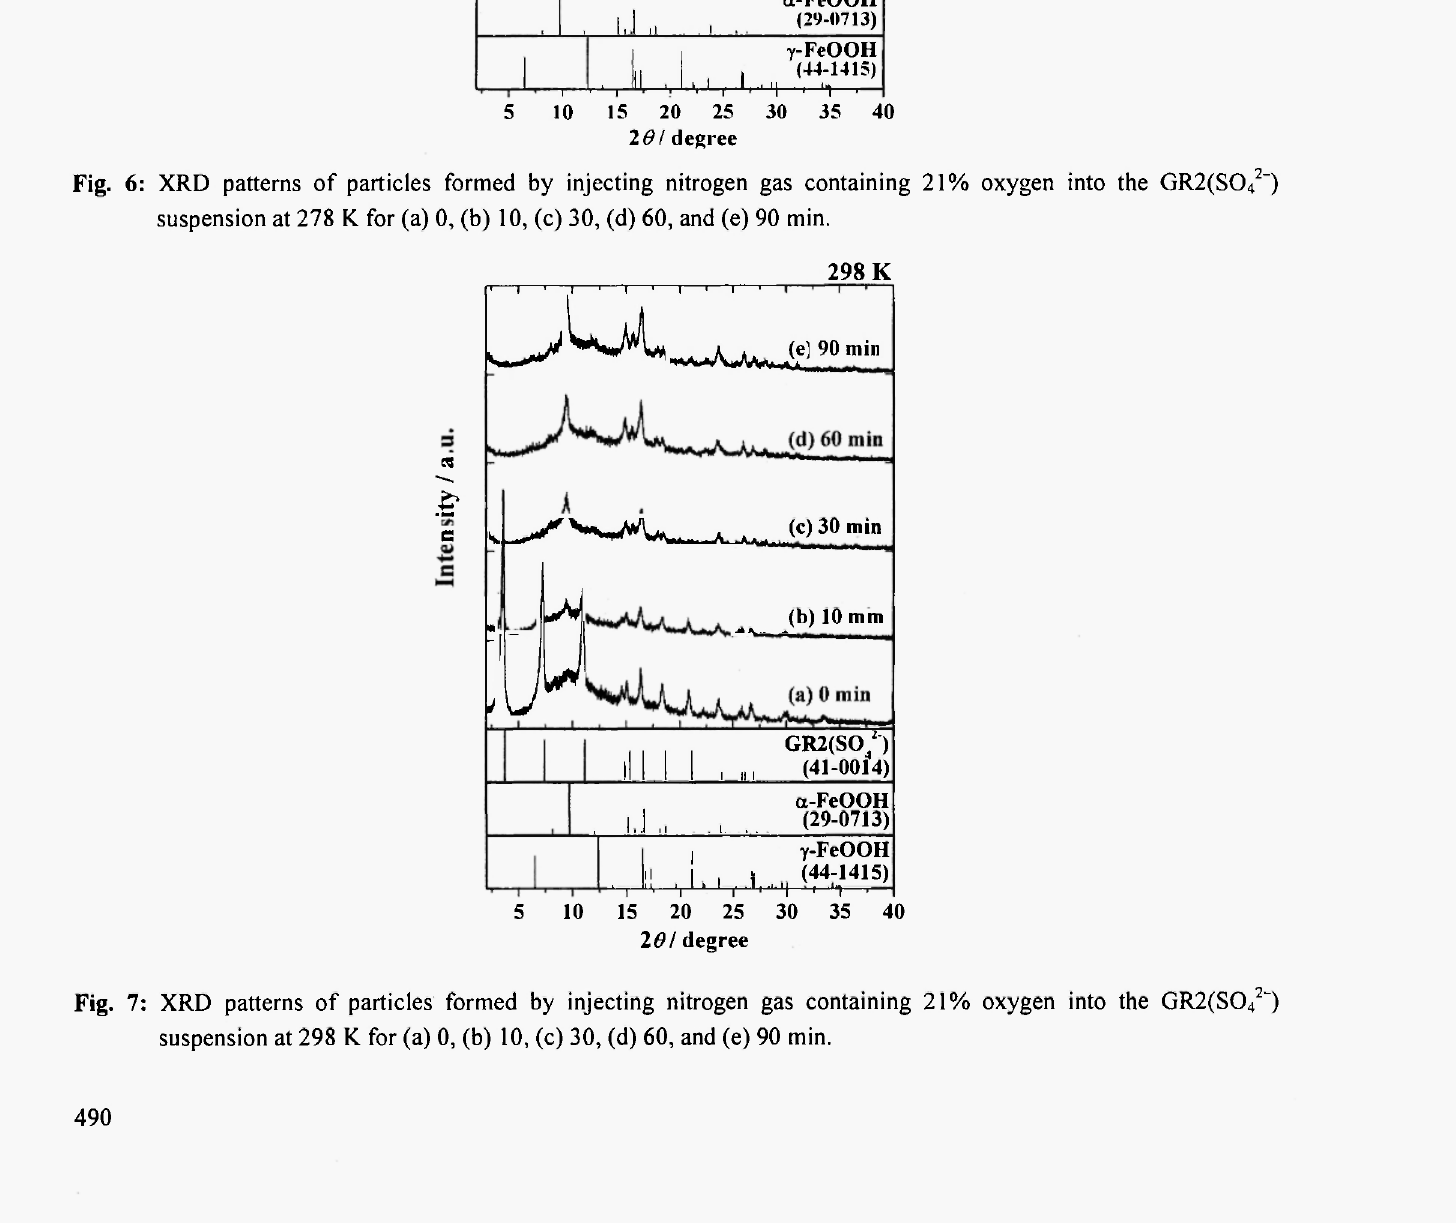
Fig. 7: XRD patterns of particles formed by injecting nitrogen gas containing 21% oxygen into the GR2(S0 4 2 ") suspension at 298 Κ for (a) 0, (b) 10, (c) 30, (d) 60, and (e) 90 min.